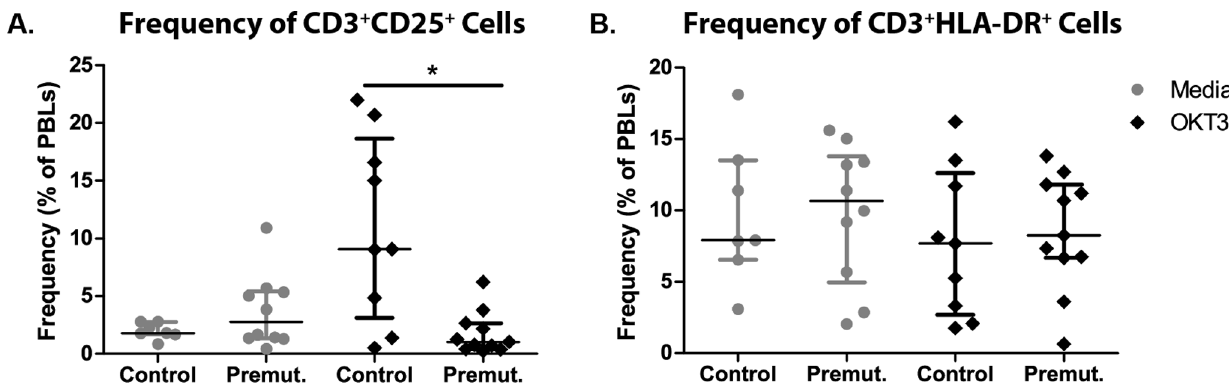
Figure 3. Cellular activation phenotype of PBLs. Frequencies of ( A ) CD3 + CD25 + cells were significantly decreased in premutation carriers compared to age-matched controls after twenty-four out culture with anti-CD3 (OKT3) and anti-CD28. No differences were apparent in ( B ) CD3 + HLA- DR + cells between groups. *p , 0.05, and p , 0.01.